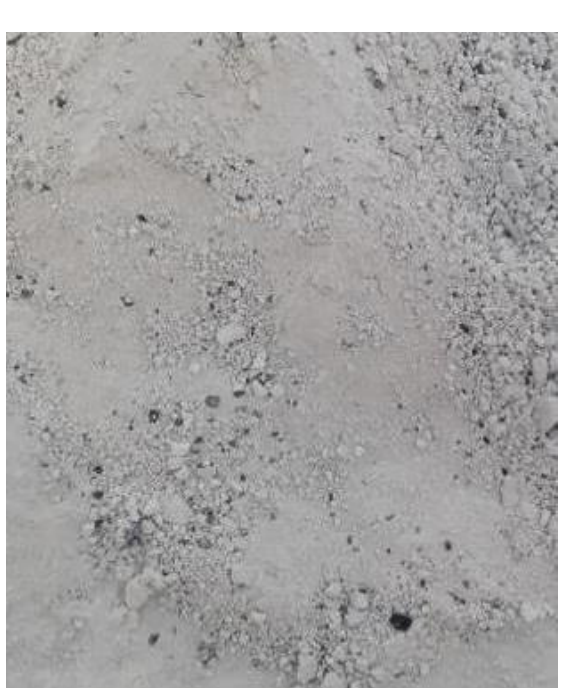
Figure 5. Gypsum powder with wooden